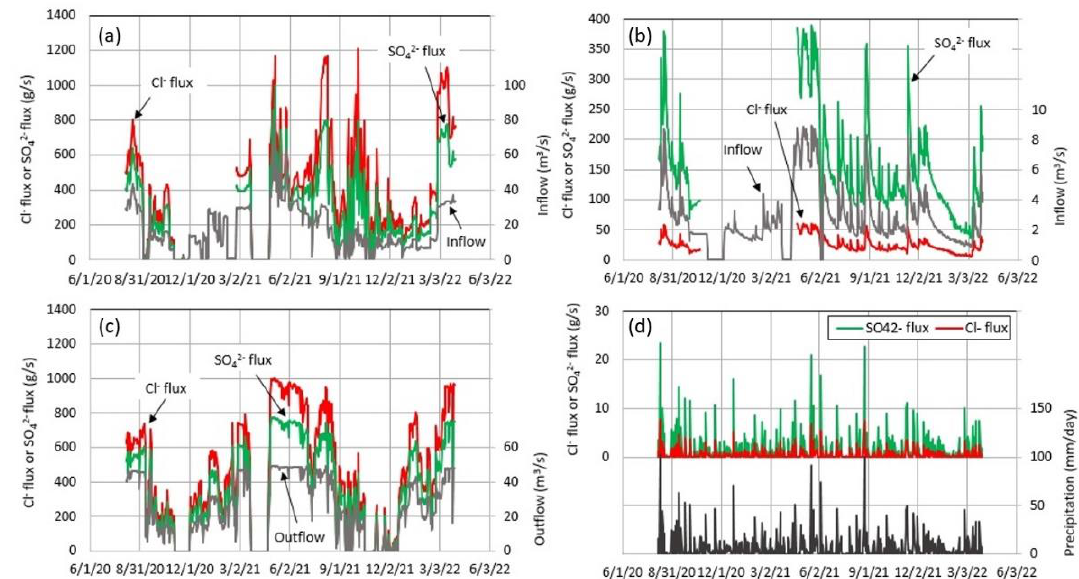
Figure 11. Temporal variations of daily mean Cl − flux and SO 42 − flux at ( a ) the conduit A, ( b ) the conduit B and ( c ) the conduit C, and ( d ) the two fluxes by precipitation for 29 June 2020–31 March 2022. Inflow at the conduits A and B, outflow at the conduit C and daily precipitation are also shown.